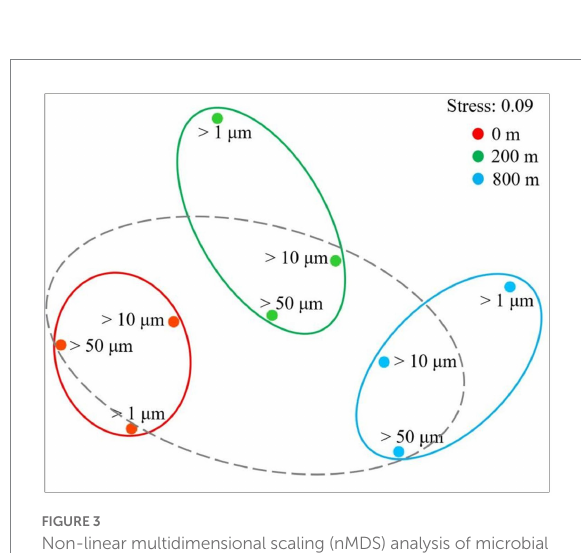
FIGURE 3 Non-linear multidimensional scaling (nMDS) analysis of microbial communities of different size-fraction particles at different water depths based on Bray-curtis